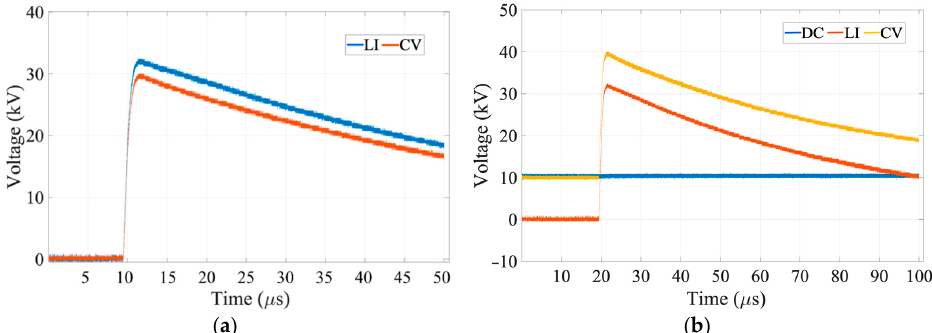
Figure 8. ( a ) The voltage at input and output of coupling capacitor; ( b ) CV generated on the experimental setup.